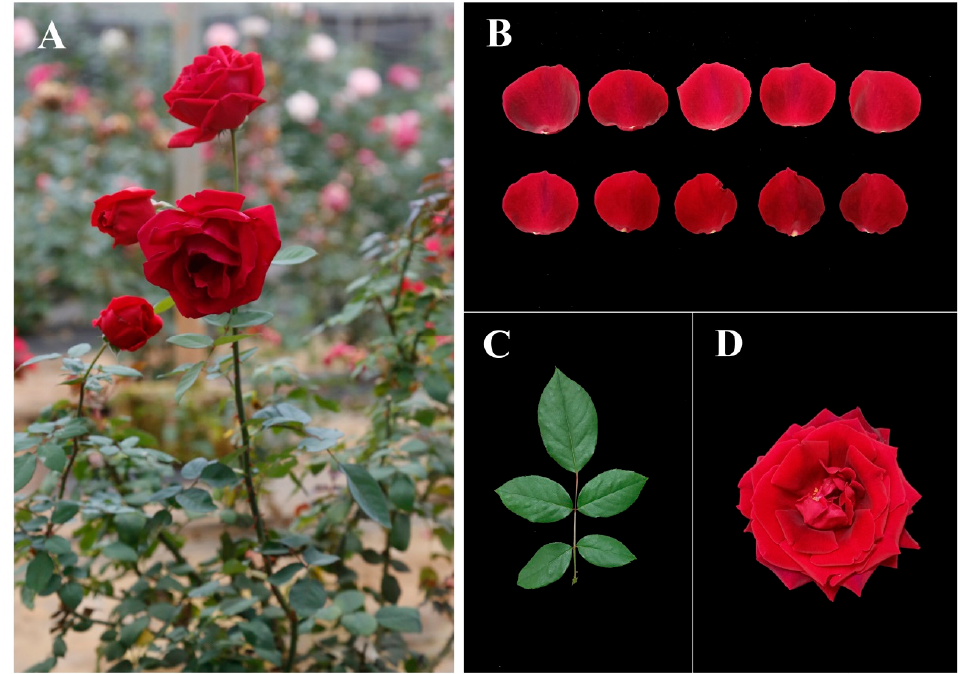
Figure 1 . Phenotypes of fl owers of R. ‘Crimson Glory’ . ( A ) Side view of the rose under growing Figure 1. Phenotypes of flowers of R. ‘Crimson Glory’. ( A ) Side view of the rose under growing conditions. ( B ) Phenotype of rose fl ower petals. ( C ) Phenotype of rose leaf. ( D ) Top view of rose conditions. ( B ) Phenotype of rose flower petals. ( C ) Phenotype of rose leaf. ( D ) Top view of rose fl owers at the blooming stage. flowers at the blooming